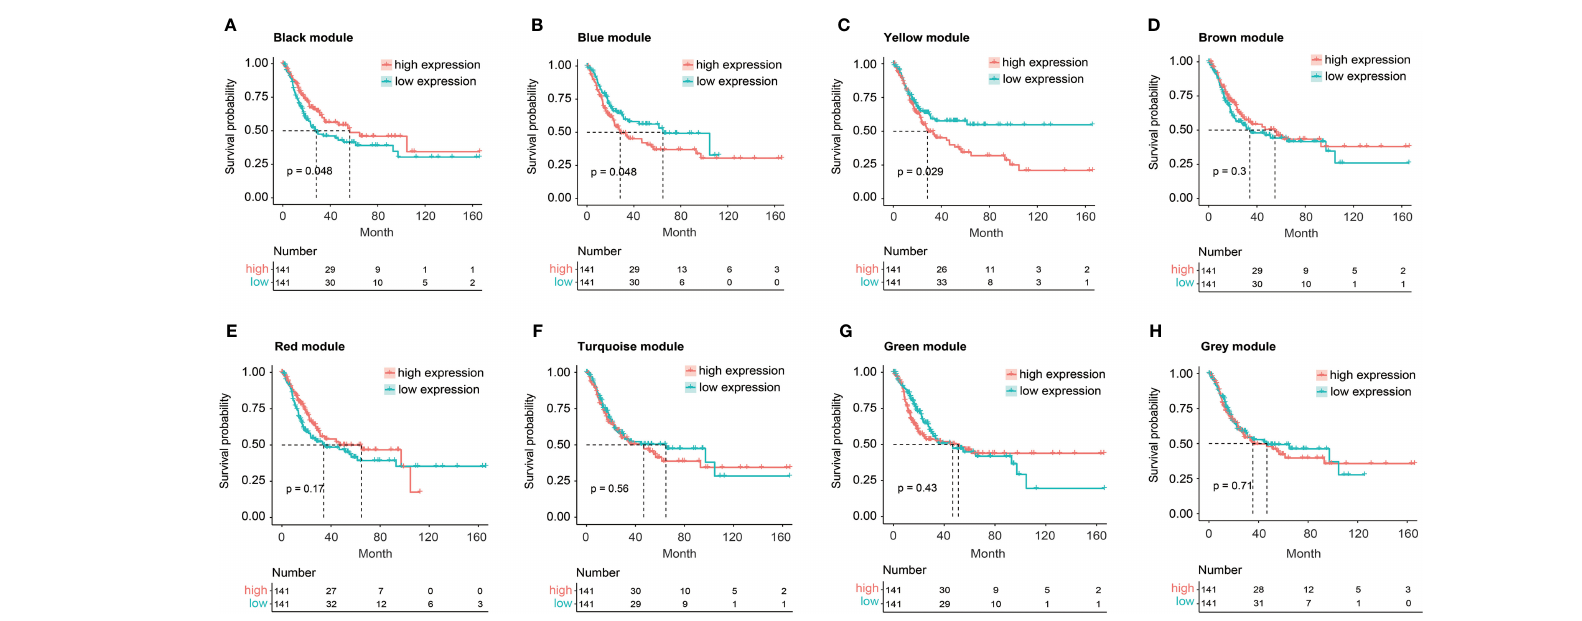
FIGURE 2 The Kaplan – Meier curve analysis for BC patients with distinct expression pattern when exploring the relationship between eight key modules and overall survival (OS) of BC patients from TCGA. (A) The expression of black module was positively correlated with OS of BC patients. (B, C) The expression of blue (B) or yellow (C) module was negatively correlated with OS of BC patients. (D – H) No statistically signi fi cant difference in OS of BC patients between high and low expression of brown (D) , red (E) , turquoise (F) , green (G) , or gray (H)